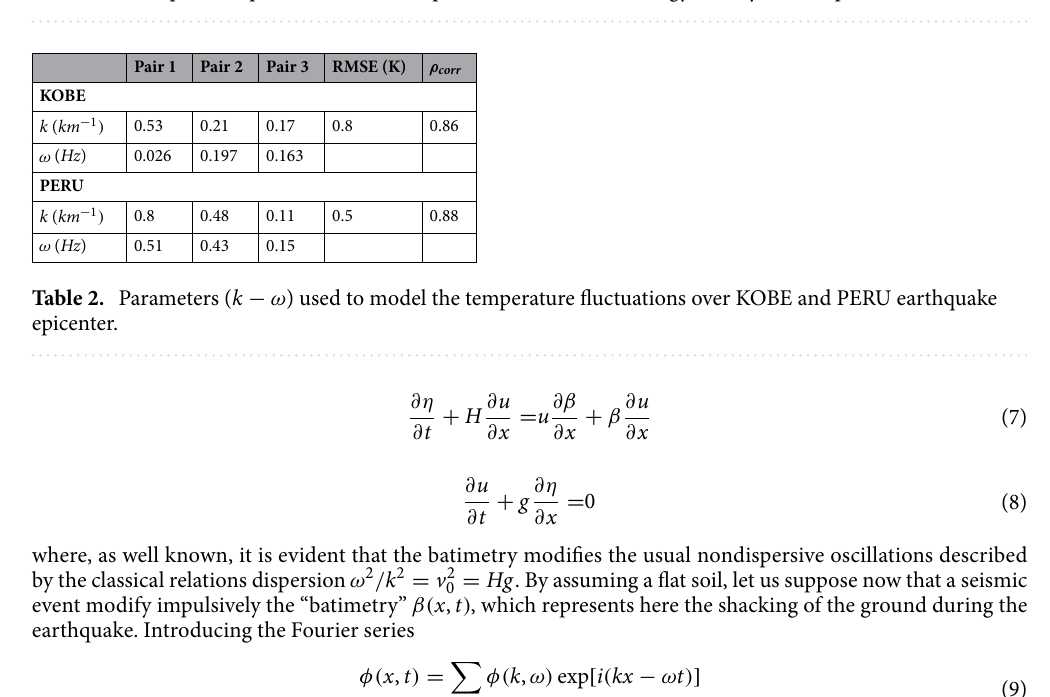
Figure 5. ( a ) Dispersion Relation evaluated for the Fiji Earthquake using the parameters in Table 1. The dashed line represents the parameter c 0 / 2 h . ( b ) Vertical Temperature profile over the EQ epicenter. ( c ) Fluctuations of the vertical temperature profile over the EQ epicenter. ( d ) Potential energy density vertical profile over the EQ.